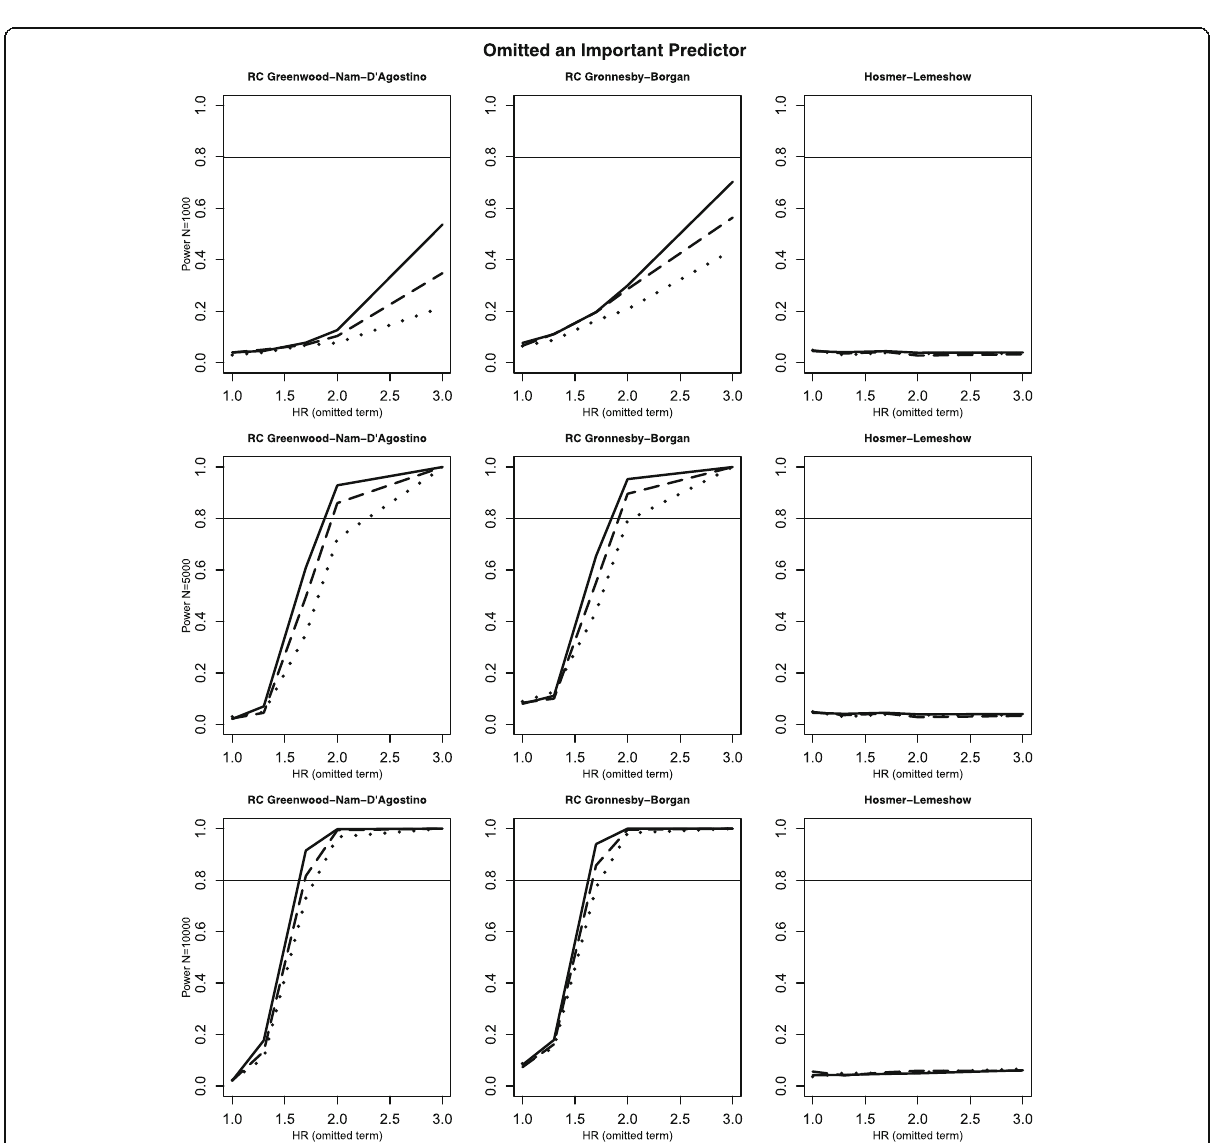
Fig. 3 Power when an important predictor is omitted for 0, 25, and 50% censoring rates. The RC statistic was calculated for the full ( y ~ x 1 + x 2 ) and reduced ( y ~ x 1 ) models. Data were simulated according to the full model, but the reduced model was used to estimate the expected proportions in the RC statistic formula. Left panel — decreasing baseline hazard, right panel — increasing baseline hazard. N = 1000 (top row), 5000 (middle row), 10,000 (bottom row), p = 0.1, collapse when ev g <